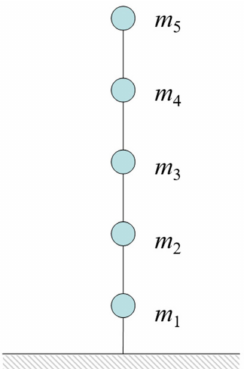
Figure 2. Simplified tower